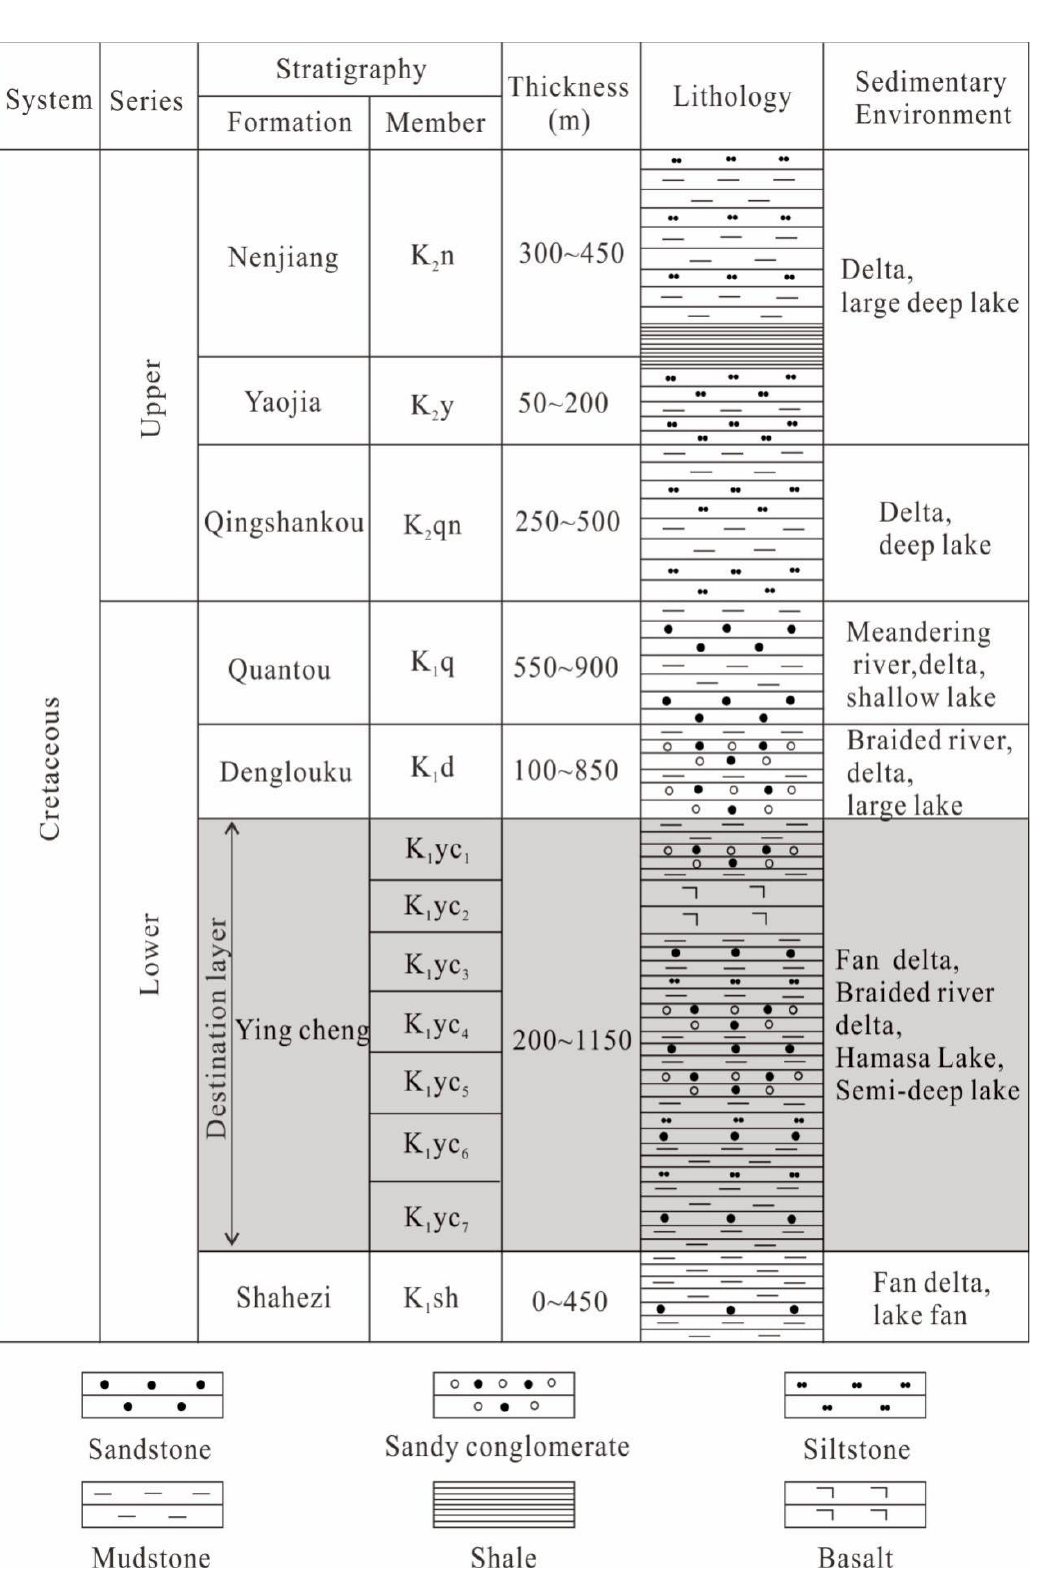
Figure 1. Geographical location of the Longfengshan subsag. ( A ) Location of the Songliao Basin. ( B ) Location of the Longfengshan subsag in the Songliao Basin. ( C ) Well location distribution in the Longfengshan subsag.